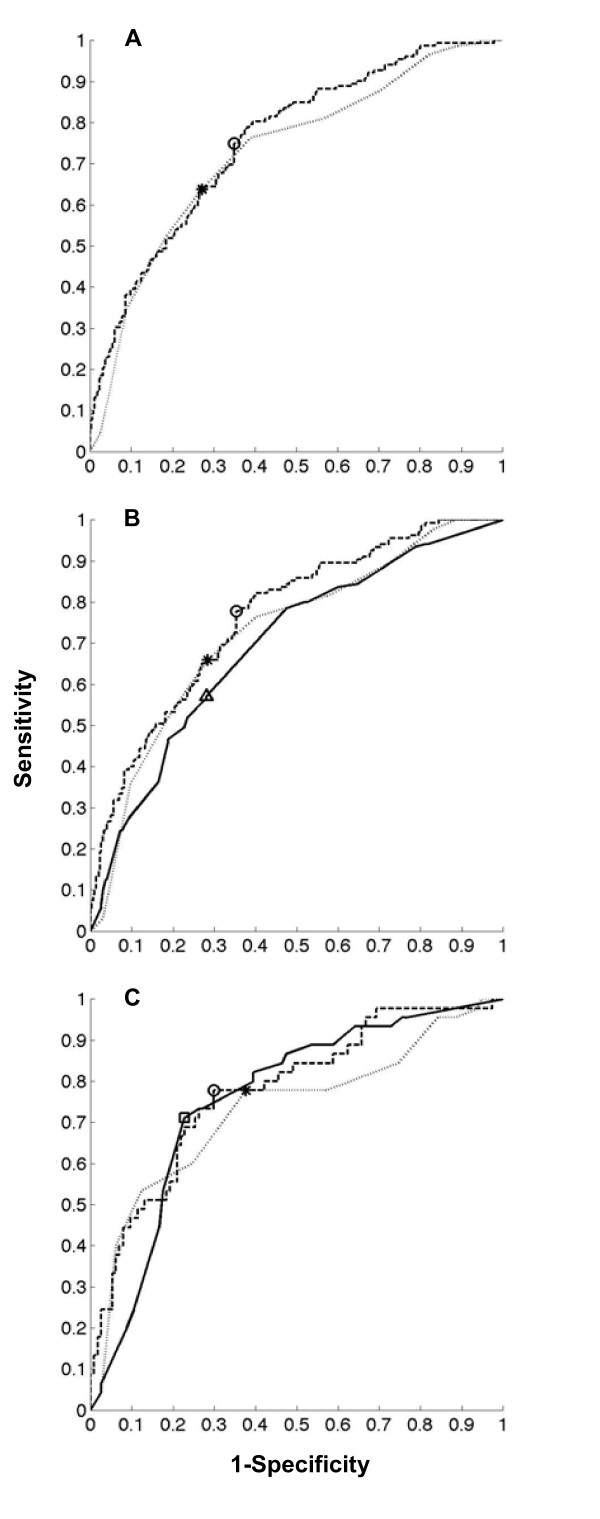
ROC of the classification task. Panel A. Validation cohort of 499 patients. ROC of the GP model (aROC = 0.758) (dark interrupted line), with a circle indicating the cutoff for best discrimination and calibration. ROC of the EuroSCORE (aROC = 0.726) (grey dotted line), with a star indicating the cutoff for best discrimination and calibration. There was no statistically significant difference between GP and EuroSCORE (p = 0.286). Panel B. Validation subcohort of 396 patients. ROC of the GP model (aROC = 0.769) (dark interrupted line), with a circle indicating the cutoff for best discrimination and calibration. ROC of the EuroSCORE (aROC = 0.726) (grey dotted line), with a star indicating the cutoff for best discrimination and calibration. ROC of the predictions by nurses (aROC = 0.695) (black uninterrupted line), with a triangle indicating the cutoff for best discrimination and calibration. The aROC of the predictions by nurses was significantly lower than the GP model (p = 0.018). Panel C. Validation subcohort of 159 patients. ROC of the GP model (aROC = 0.777) (dark interrupted line), with a circle indicating the cutoff for best discrimination and calibration. ROC of the EuroSCORE (aROC = 0.726) (grey dotted line), with a star indicating the cutoff for best discrimination and calibration. ROC of the predictions by ICU physicians (aROC = 0.758) (black uninterrupted line), with a triangle indicating the cutoff for best discrimination and calibration. The aROC of the predictions by ICU physicians was not significantly different from the GP model (p = 0.719).